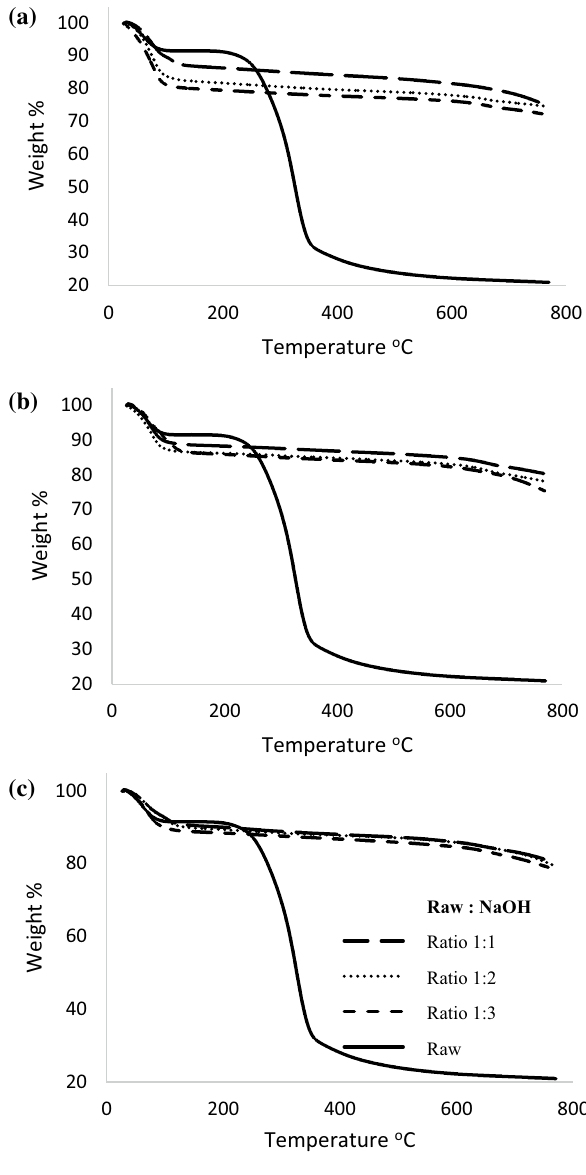
Fig. 4 Thermal gravimetry curve for samples produced at 700 °C ( a ), 750 °C ( b ), and 800 °C ( c ) activation